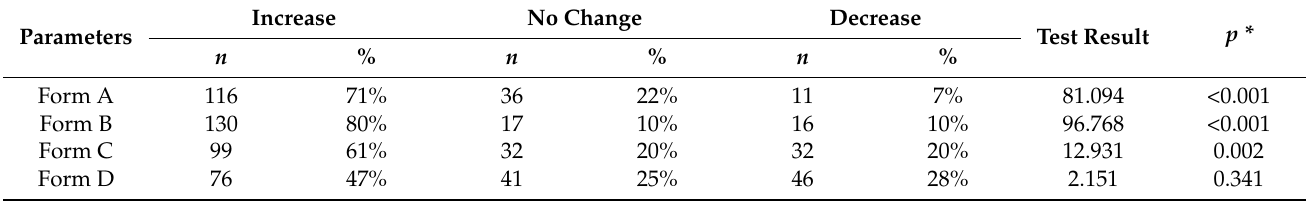
Table 4. Effects of treatment on total counts of sperm motility forms in the ejaculate.